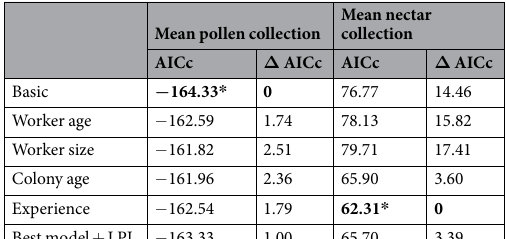
Table 1. Candidate models to predict pollen and nectar collection efficiency by tested bees. The basic model contained only the intercept and colony membership as a random factor. All other models contained the basic model and the additional fixed factors (predictors) specified in the model name. The model with the lowest AICc value out of the five initial models (indicated with an asterisk) had learning ability performance (LPI) added to it to determine whether this significantly decreased the AICc value (i.e. Δ AICc > 2). The best model (based on the AICc value) is shown in